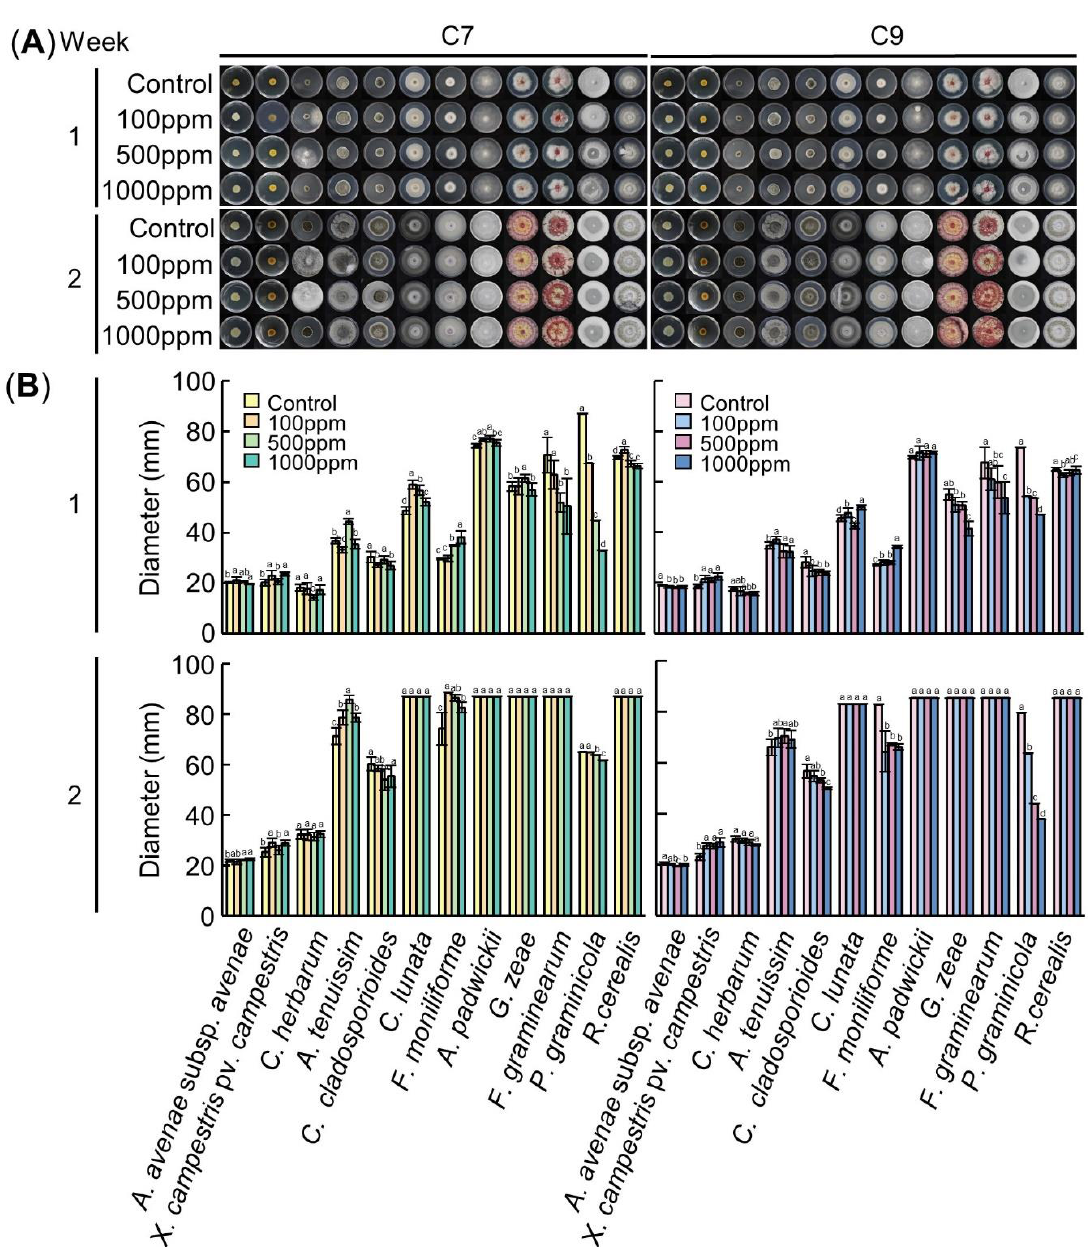
Figure 3. Antimicrobial activity of C7 (left panel) and C9 (right panel). (A)Visual growth of different bacterial and fungal strains. Bacteria were cultured in an LB medium and fungi were cultured in a PDA medium at 25 °C in a dark state. The medium was treated with C7 and C9 at concentrations of 0 ppm, 100 ppm, 500 ppm and 1000 ppm, respectively. Colonies were observed after 1 and 2 weeks of growth after inoculation. (B) Colony diameter according to the concentration of the compounds at 1 week and 2 weeks after inoculation. Means with the same letters are not significantly different by Duncan’s multiple range test at p < 0.05.